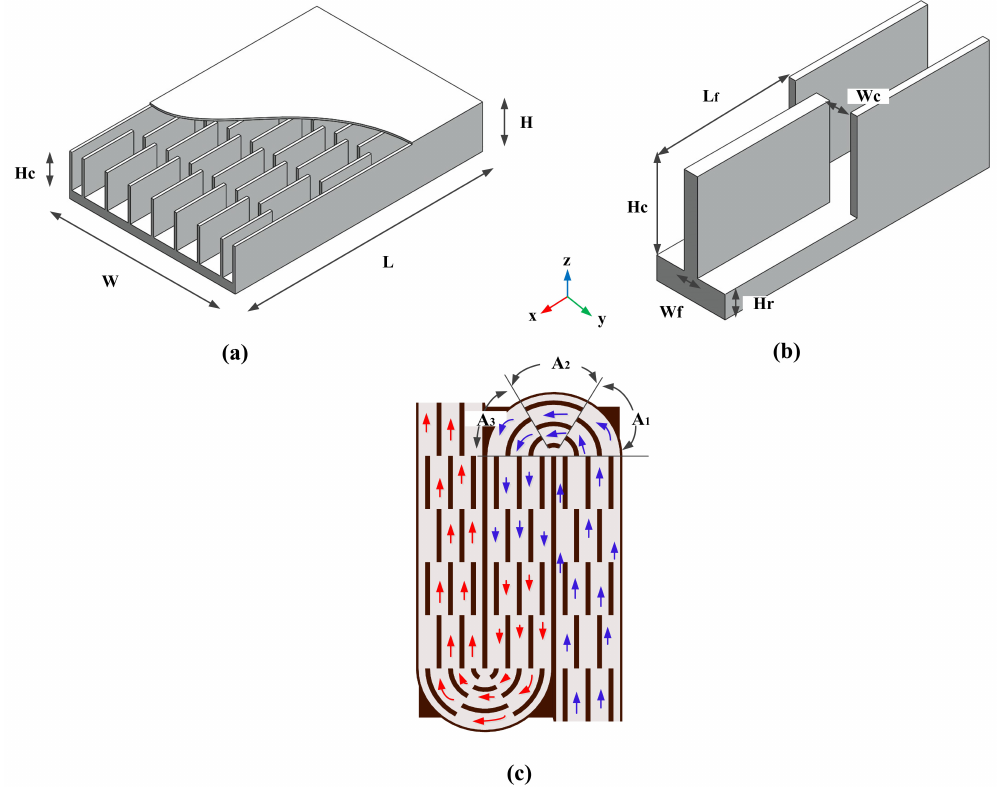
Figure 4. Geometries of ( a ) 3D Offset strip fin heatsink, ( b ) Detailed dimensions of a channel with fins, ( c ) New offset design (Blue and red arrows show inlet and outlet flow,